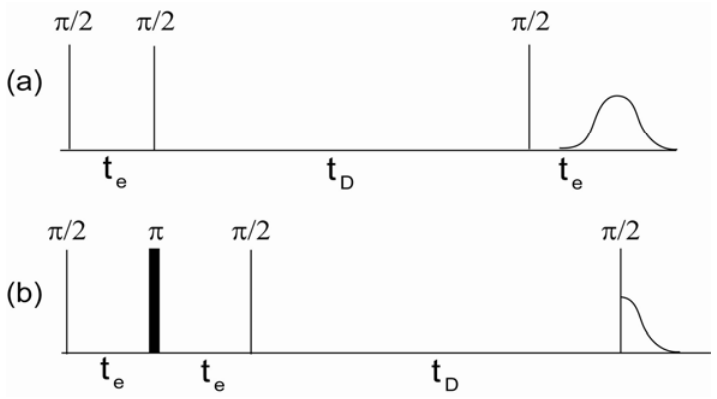
Figure 1. ( a ) Decay due to diffusion in the internal field (DDIF) and ( b ) reference pulse sequences. (cid:1872) and (cid:1872) are the encoding and diffusion time periods, respectively. Stimulated (cid:3032) (cid:3031) echoes were detected by DDIF and free induction decay for the reference scan. Reproduced from Reference [12] with